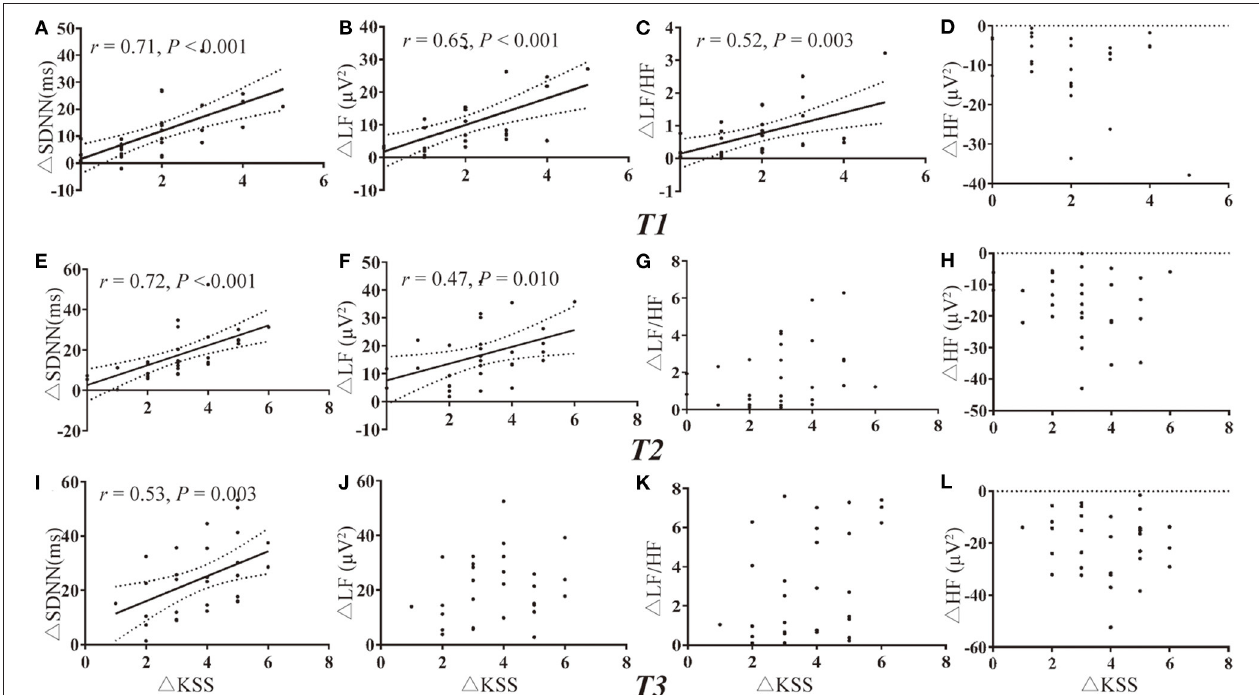
FIGURE 4 | Correlations of HRV variations with the change in KSS. (A–D) Correlation of 1 KSS with the change in HRV parameters at T1. (E–H) Correlation of 1 KSS with the change in HRV parameters at T2. (I–L) Correlation of 1 KSS with the change in HRV parameters at T3. HF indicates high frequency; HFnu, normalization of